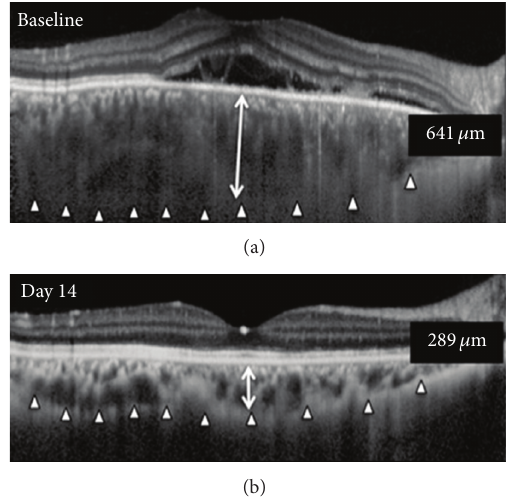
Figure 2: Enhanced depth optical coherence tomographic B-scan of the right eye of a 35-year-old patient with VKH taken using Heidelberg Spectralis OCT (Heidelberg Engineering, Germany). Arrowheads delineate the outer border of the choroid. At base- line subfoveal choroidal thickness of 641 𝜇 m with serous retinal detachment, this was reduced with steroid therapy by day 14 to 289 𝜇 m with resolution of serous retinal detachment. (Reprinted withpermissionfrom“Subfovealchoroidalthicknessaftertreatment of Vogt-Koyanagi-Harada disease”